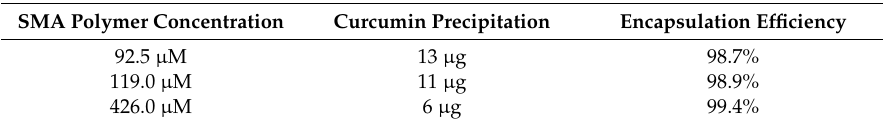
Table 3. Release efficiency of curcumin at day 3 at pH 4, 5, and 6 of a final concentration of 31.7, 63.4, and 111 µM of SMA diluted in water from initial SMA concentrations in Figure 2 and Table 2.